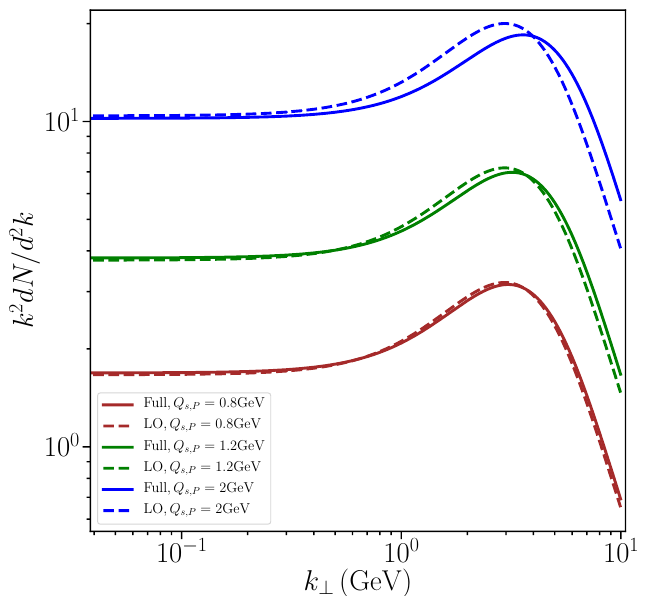
Figure 5. Full result resumming all order initial state effect versus leading order result. The target saturation scale is chosen to be Q s,T = 2 . 0 GeV